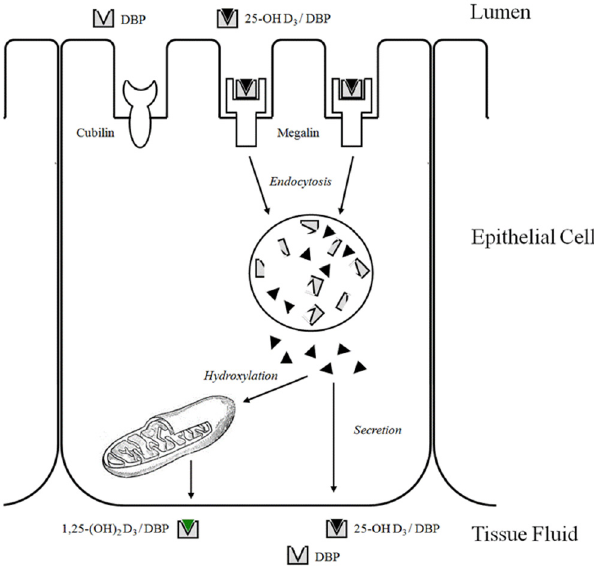
Fig 1. Model of megalin function in renal uptake and activation of 25-(OH) Vitamin D3.